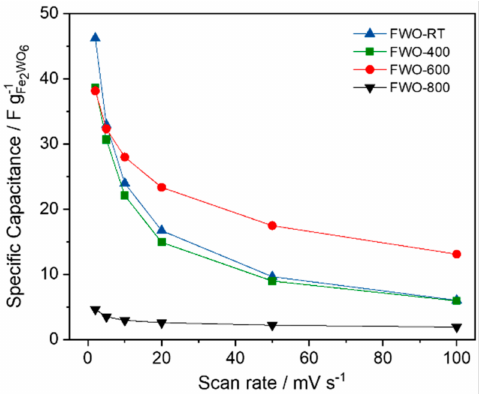
Figure 3. Evolution of the specific capacitance in F g − 1 vs. scan rate in 5M LiNO 3 for the selected Fe 2 WO 6